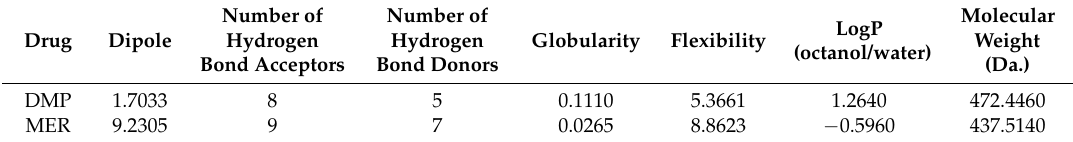
Table 1. Physical descriptors of dexamethasone phosphate (DMP) and meropenem (MER).